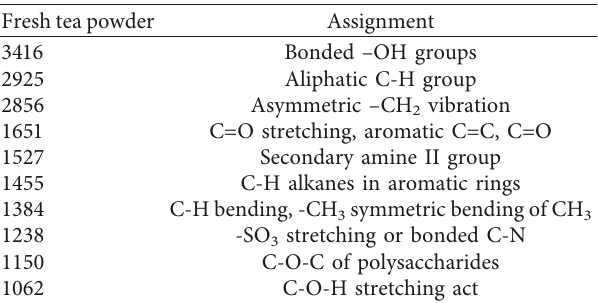
Figure 2: SEM photograph of wasted tea powder. Table 1: The main functional groups of wasted oolong tea powder.